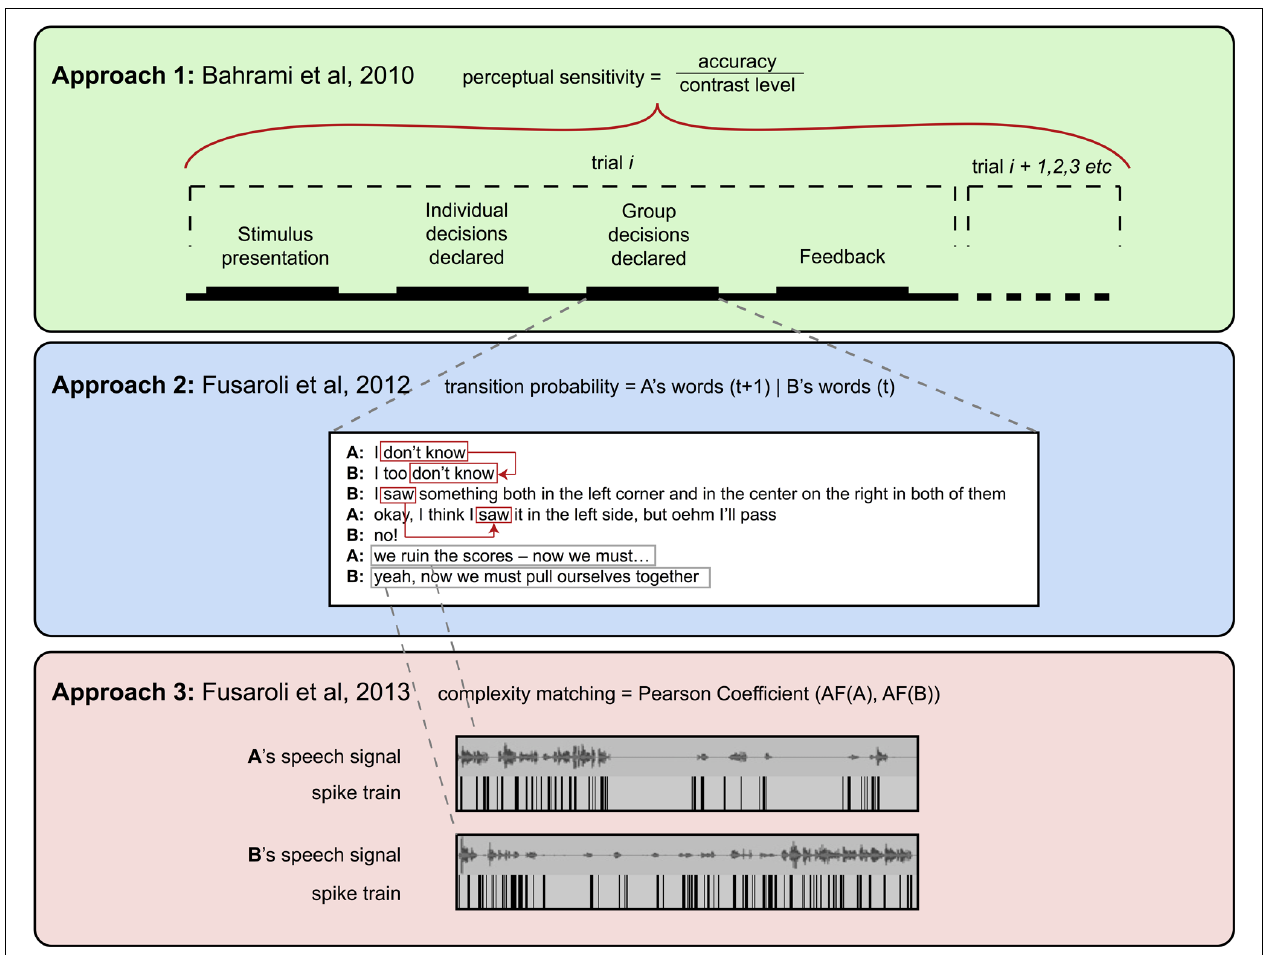
FIGURE 2 |The three approaches to decision-making paradigm discussed here, with an indication of their characteristic temporal and spatial scales as well as their favored methodological